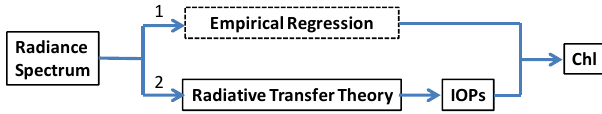
Fig. 1. Conceptual diagram of the OC3M (route 1), and the GSM and GIOP (route 2).